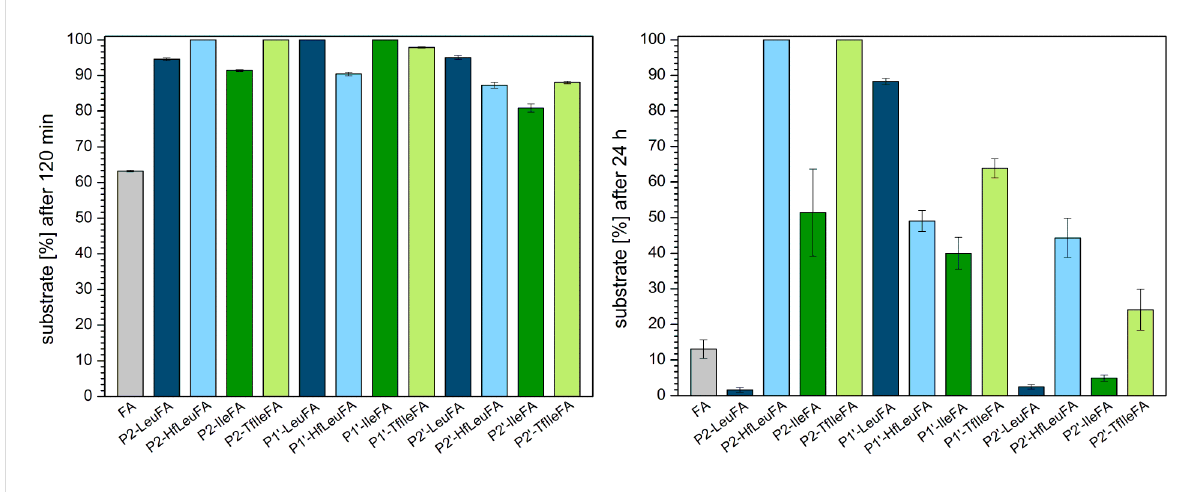
Figure 2: Percentage of substrate remaining after incubation for 120 min (left) and 24 h (right) with α - chymotrypsin in 10 mM phosphate buffer, pH 7.4, at 30 °C. The data shown represent the average of three independent measurements. Errors are derived from the standard deviation.